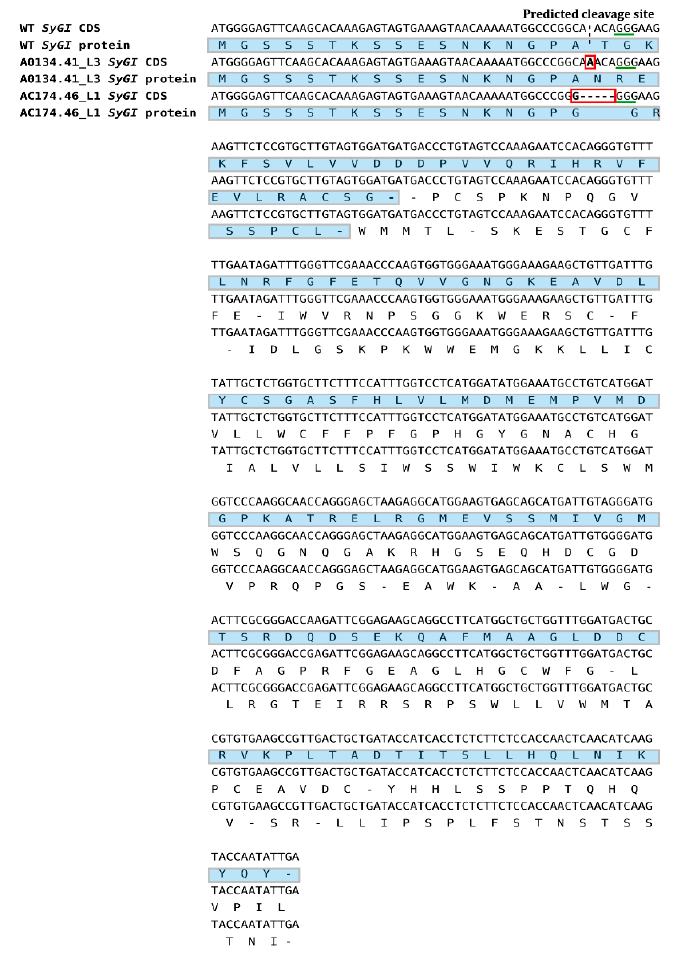
Figure 5. CRISPResso output analysis for the two regenerated lines named A0134.41_L3 (on the left) and Ac174.46_L1 (on the right). The two plots allow the quantification and visualization of the position and type of outcomes within the amplicon sequence reporting the frequency of mutations detected across sgRNA1 locus in this case. The reference amplicon position in the base pair is re- ported on the X-axis, while the Y-axis reports the percentage of reads showing mutations, with the effective number of mutations in brackets. Mutation types are color-coded: insertions are in red, deletions are purple, and substitutions are green.